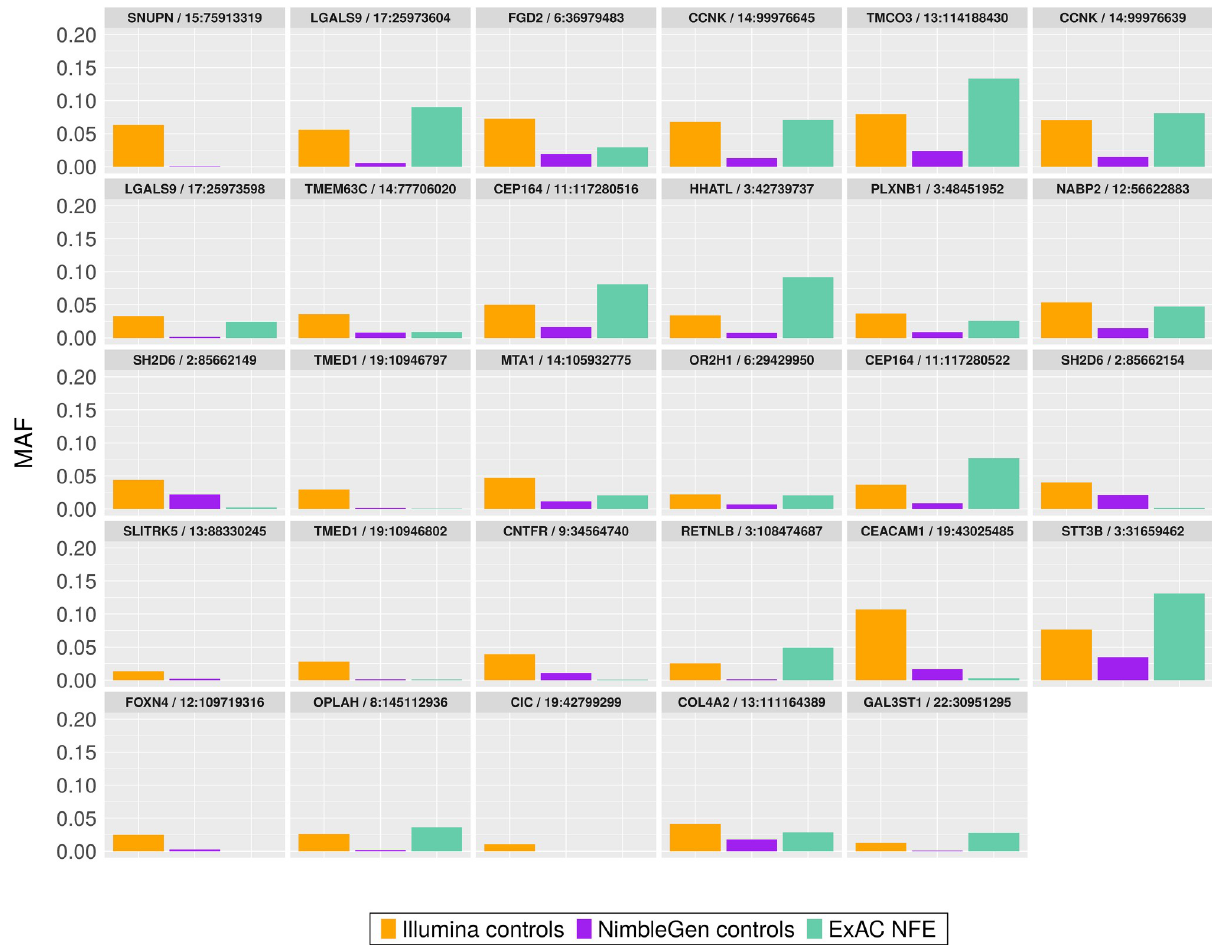
Fig 5. Minor Allele Frequency (MAF) of 29 exome-wide significant SNPs in AD control exomes processed by two capture kits and in the ExAC Non-Finnish European (NFE) population.